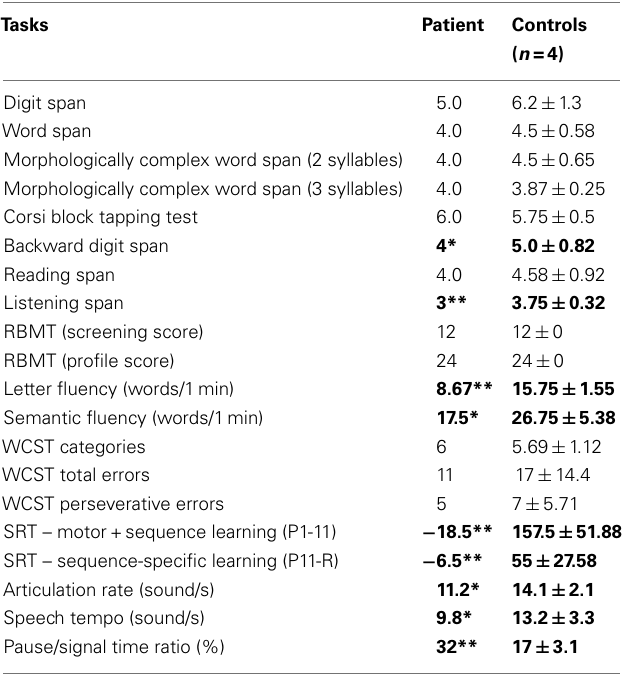
Table 1 | Patient and control group performance on neuropsychological